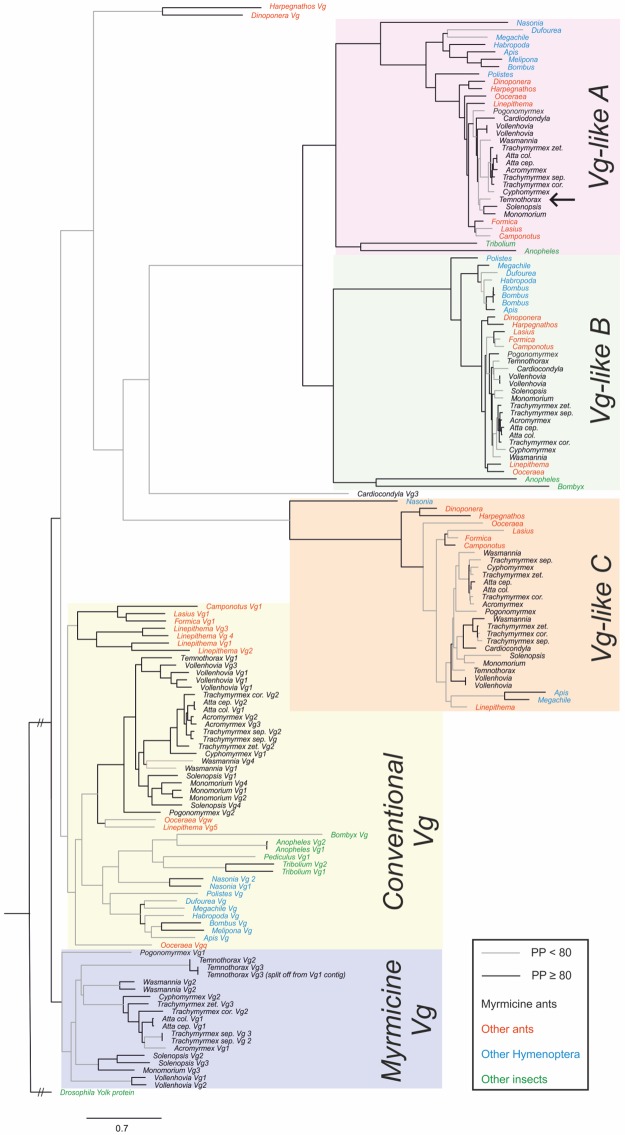
RAxML maximum likelihood tree of all Vg and Vg-like copies found in 33 social and solitary insects.One cluster of conventional Vgs, 3 Vg-like clusters, and 1 myrmicine specific cluster were identified. Vg/Vg-like copies are color coded. Within each cluster, genes are grouped according to taxonomic groups. The gene knocked down in this study fell into the Vg-like A cluster (indicated by the black arrow). PP, posterior probability; Vg, vitellogenin.